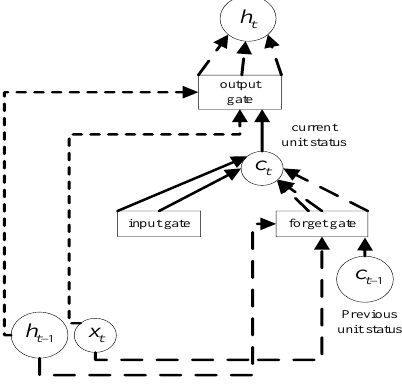
Figure 3. LSTM structure diagram.